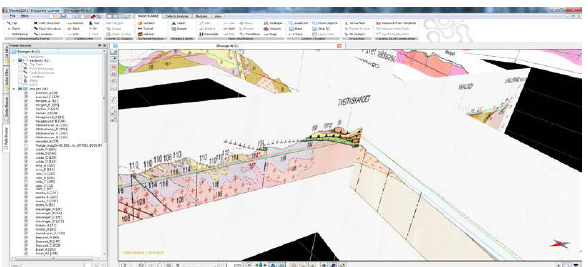
Figure 2: Screen dump from 3DMOVE showing the mismatch between two intersecting 250K profiles.